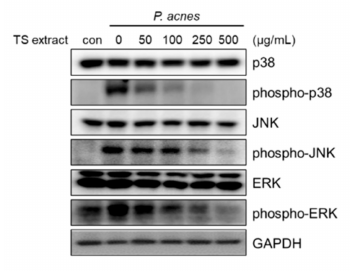
Figure 6. E ff ect of TS extract on the MAPK signaling pathway in P. acnes -treated HaCaT cells. Cells were pretreated with indicated concentrations of TS extract for 2 h and then treated with P. acnes for 2 h. The levels of p38, phospho-p38, JNK, phospho-JNK, ERK, and phospho-ERK were compared by Western blotting. GAPDH was used as a loading